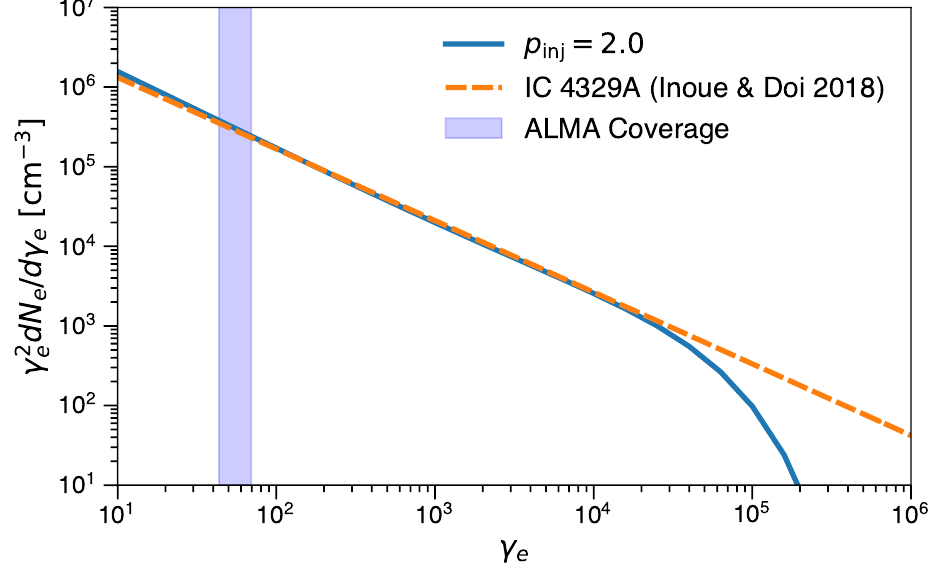
Figure 8. The steady-state electron spectral distribution in AGN coronae. Solid curve corresponds to the model with p inj = 2.0. Dashed curve corresponds to the observationally determined electron distribution for IC 4329A [37]. The shaded region shows the Lorentz factors responsible for the observed radio